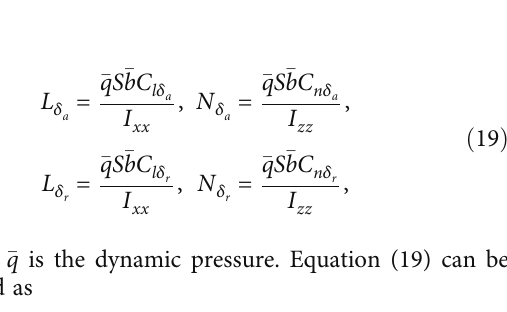
Figure 8: Diagram of roll – yaw control coupling. (a) Roll control coe ffi cients due to the ailerons and rudder de fl ection (per radian). (b) Yaw control coe ffi cients due to the aileron and rudder de fl ection (per radian).